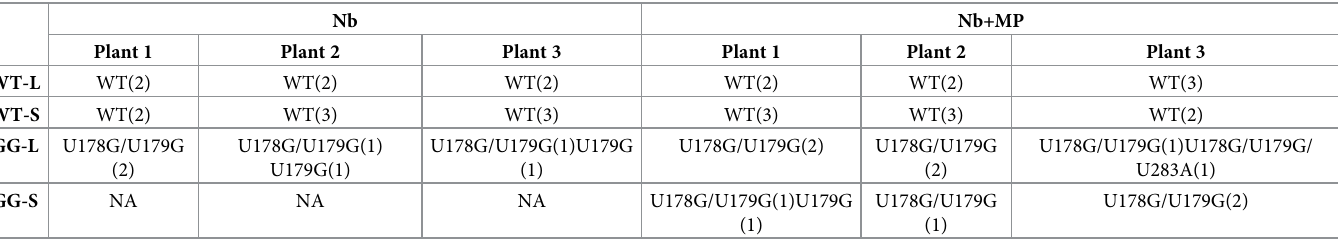
Progeny obtained from both inoculated (L, local) or systemic (S) leaves of three Nb and three Nb+MP plants inoculated with WT PSTVd or the GG mutant were cloned and sequenced. Numbers in parentheses indicate number of clones containing the sequence. NA, not